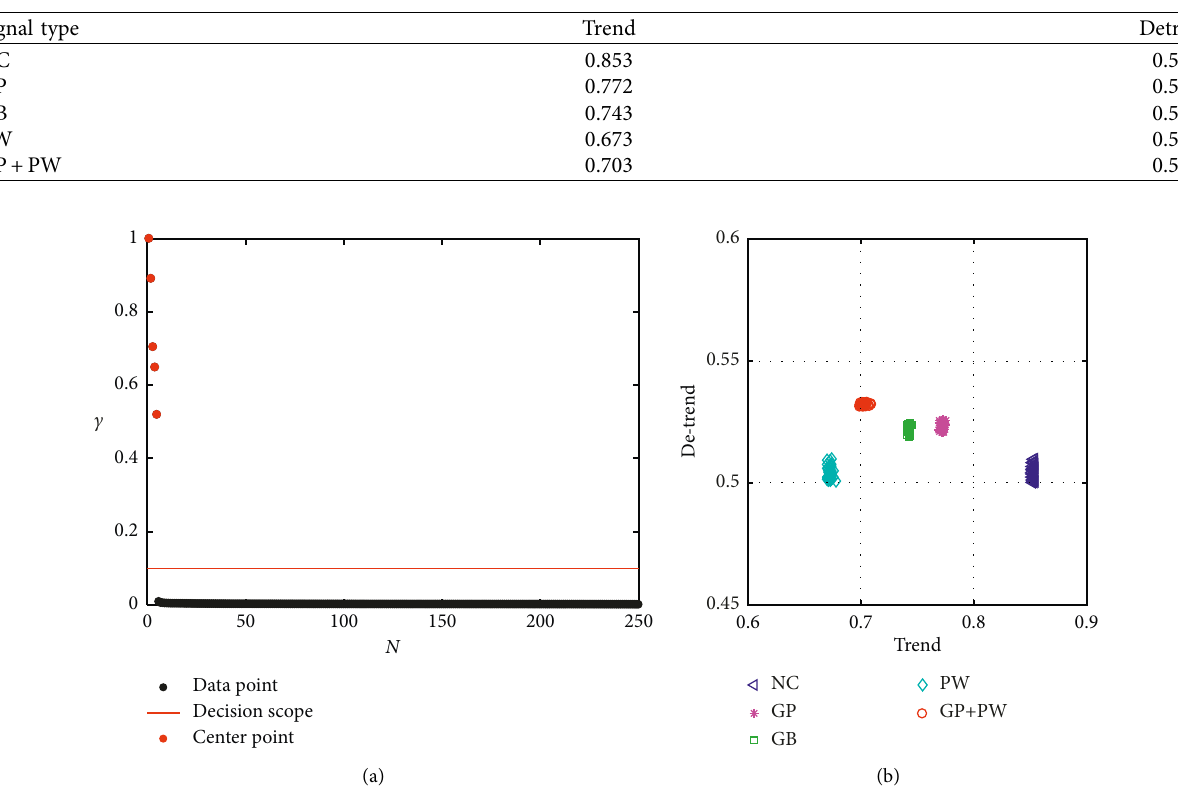
Figure 14: The clustering result of the gearbox by using the SPA-FDE-DPC: (a) decision graph and (b) clustering